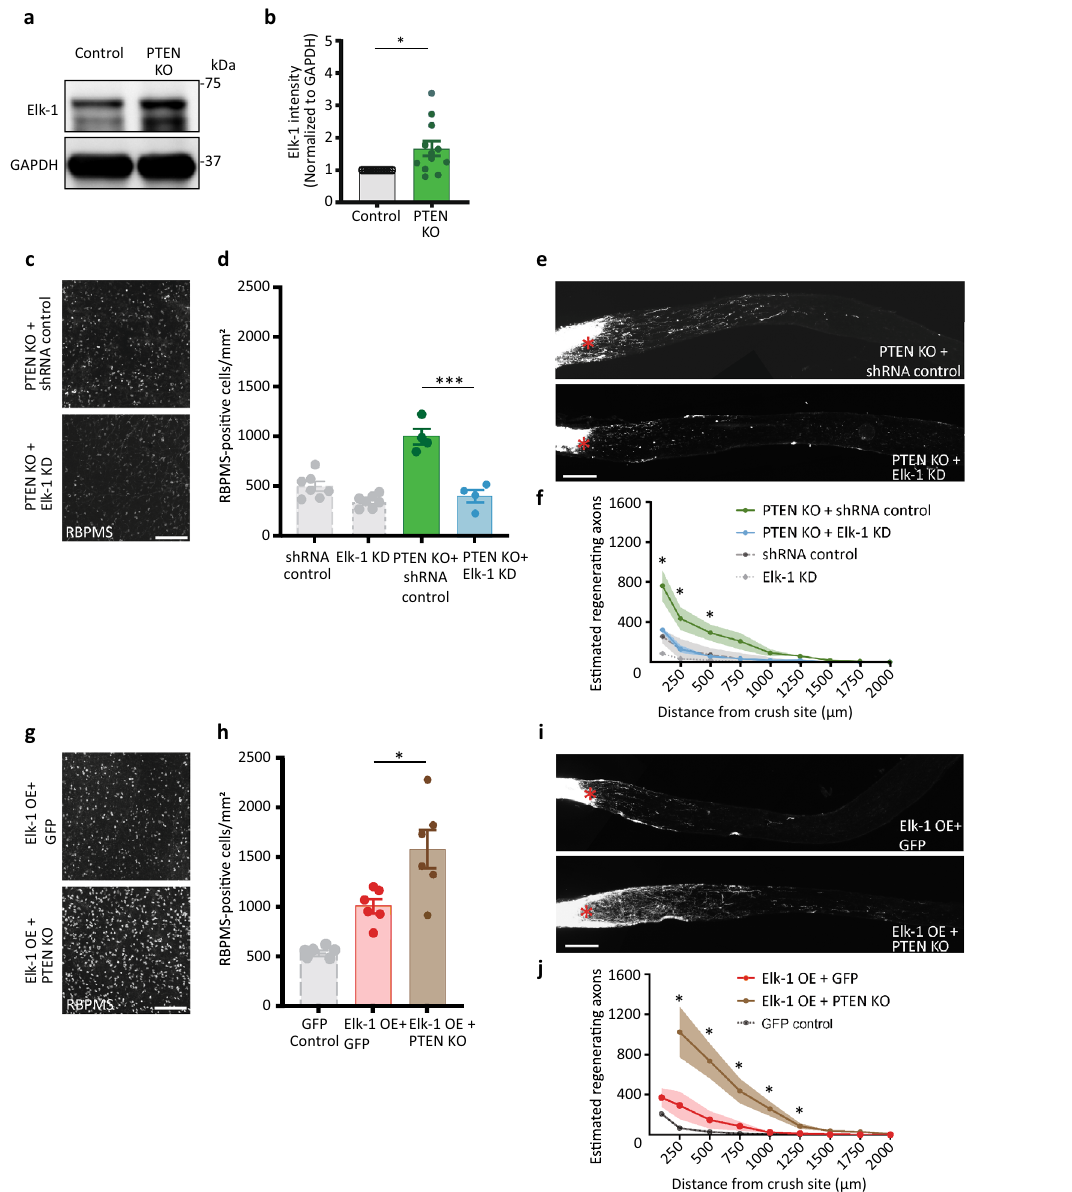
Figure 4. Elk-1 is downstream of PTEN for RGC survival and regeneration. ( a ) Expression of Elk-1 in whole retinas of PTEN flox/flox mice at 2 weeks after intravitreal injection with either AAV2-GFP or AAV2-Cre-GFP. Full blot in Supplemental Fig. S2. ( b ) Quantitative analysis of PTEN KO-induced activation of Elk-1 in whole retinas in ( a ). n = 12, * P < 0.05, two-tailed paired t-test. ( c ) Representative images show RBPMS staining of RGCs at day 14 after optic nerve crush, for either AAV2-Cre-GFP + AAV2-shRNA-Luciferase or AAV2-Cre-GFP + AAV2-shRNA-Elk-1 injected PTEN flox/flox mice. ( d ) Quantitative analysis of RBPMS-positive cell number in the retinas in c . n = 4 per